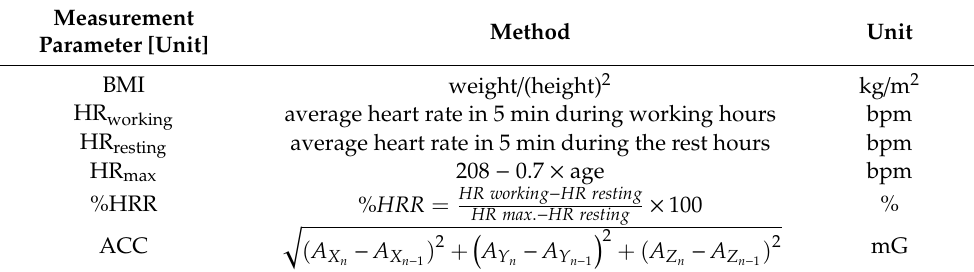
Table 2. Measurement parameters and measurement